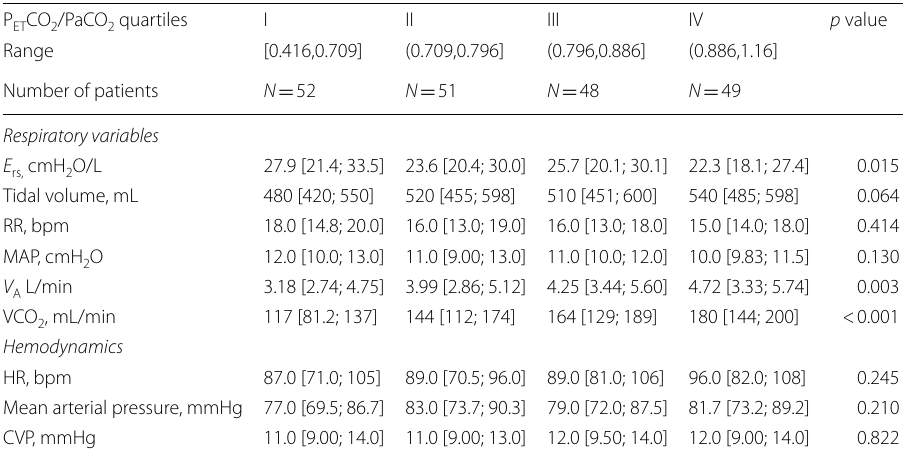
CO /PaCO ratio quartiles ET 2 2